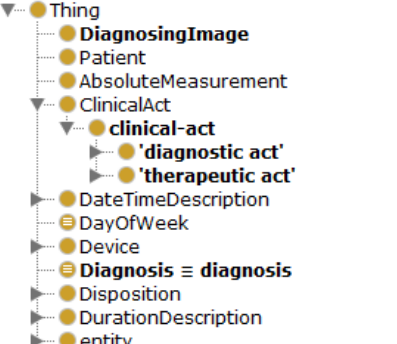
Figure 2. The partial classes of the ―Problem-Oriented Medical Record Ontology‖ in